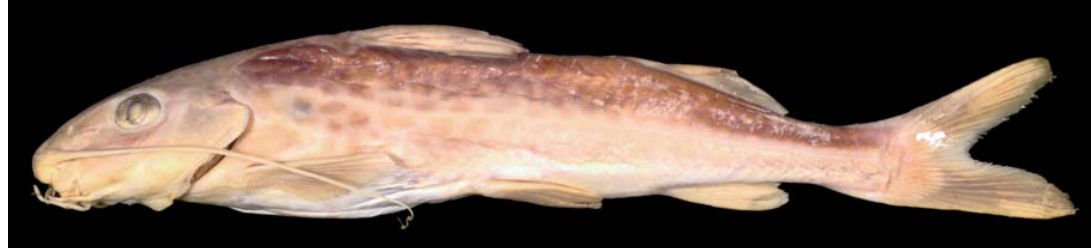
Fig. 1. Lateral view of Pimelodus ortmanni , FMNH 54240, holotype, 164.0 mm SL, rio Iguaçu, União da Vitória.